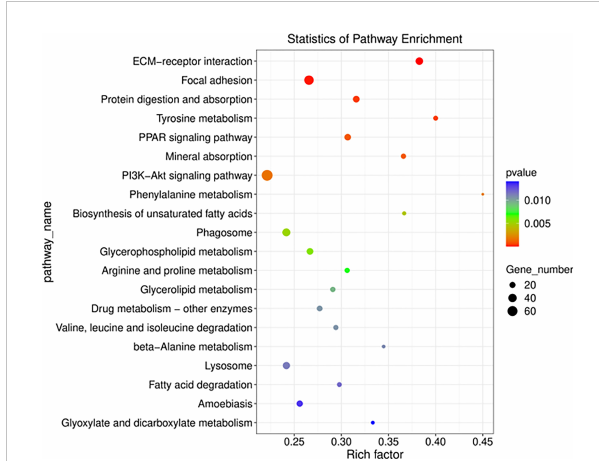
FIGURE 6 Functional annotation and KEGG pathway enrichment analyses for co-expressed DEmRNAs of DElncRNAs. The size of the spot indicates the gene numbers enriched in the pathway, and the color of the spot indicates the signi fi cance level of the enriched pathway. The abscissa is the enrichment score. Size represents the number of enriched genes, and color indicates the degree of enrichment. Higher enrichment scores correlate with lower P-values, indicating that the enrichment of differentially expressed genes in given pathway is signi fi